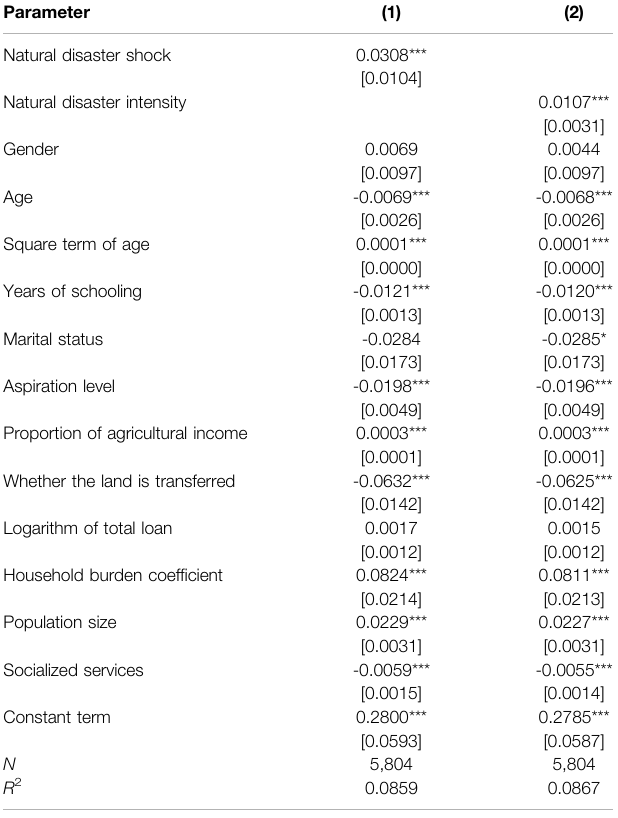
TABLE 2 | Impact of natural disasters on farmers ’ relative